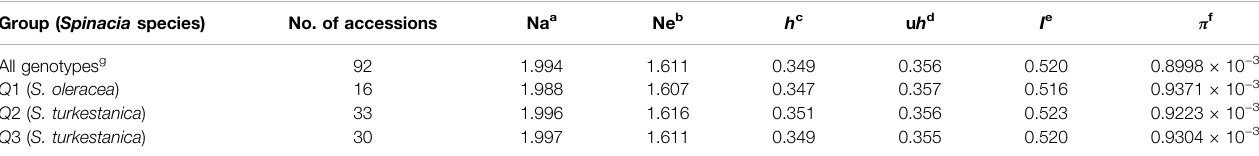
( Table 1 ). The average F st and gene fl ow (Nm) was 44.5 among three groups of the two species. The greatest F st, 0.012, was between groups Q 2 and Q 3, both of which consisted of accessions of S. turkestanica , followed by 0.011 for group Q 1 of S. oleracea and Q 3 of S. turkestanica , and then 0.008 between the Q 1 and Q 2 groups ( Table 2 ). The genetic distance, D , followed the same pattern, with the largest D between groups Q2 and Q3 , and the smallest between groups Q 1 and Q 2. The genetic identity, I d , was greatest for Q1 and Q2 (0.993), followed by Q1 and Q3 (0.989), and Q2 and Q3 (0.988). Consequently, the highest Nm was between Q 1 and Q 2 (30.13), followed by Q 1 and Q 3 (21.83), and Q 2 and Q 3 (19.77) ( Table 2 ). alleles (Ne), diversity index ( h ), unbiased diversity index (u h ),